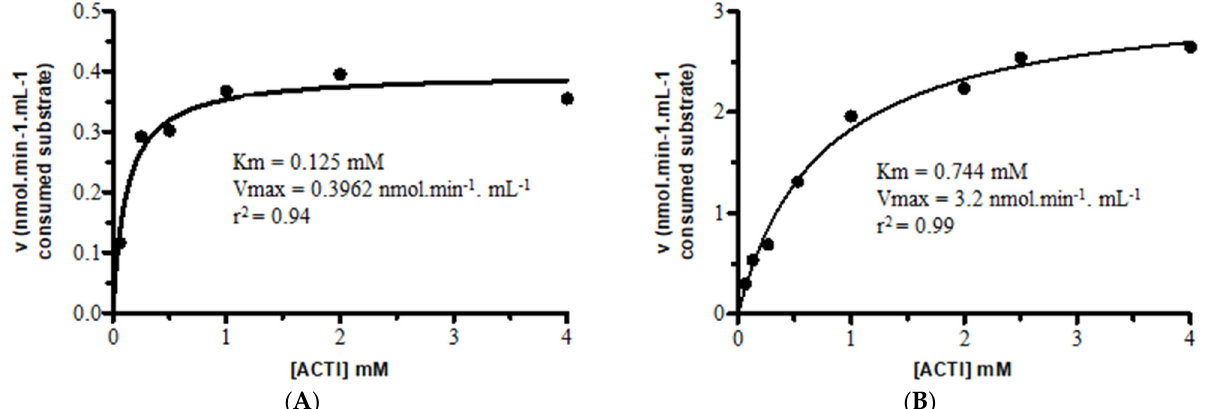
Figure 1. Determination of the kinetic parameters of AChE and BuChE under steady-state conditions. ( A ) Km and Vmax values of AChE against the substrate (ACTI). ( B ) Km and Vmax values of BuChE against the substrate (ACTI). Values were calculated using non-linear regression.